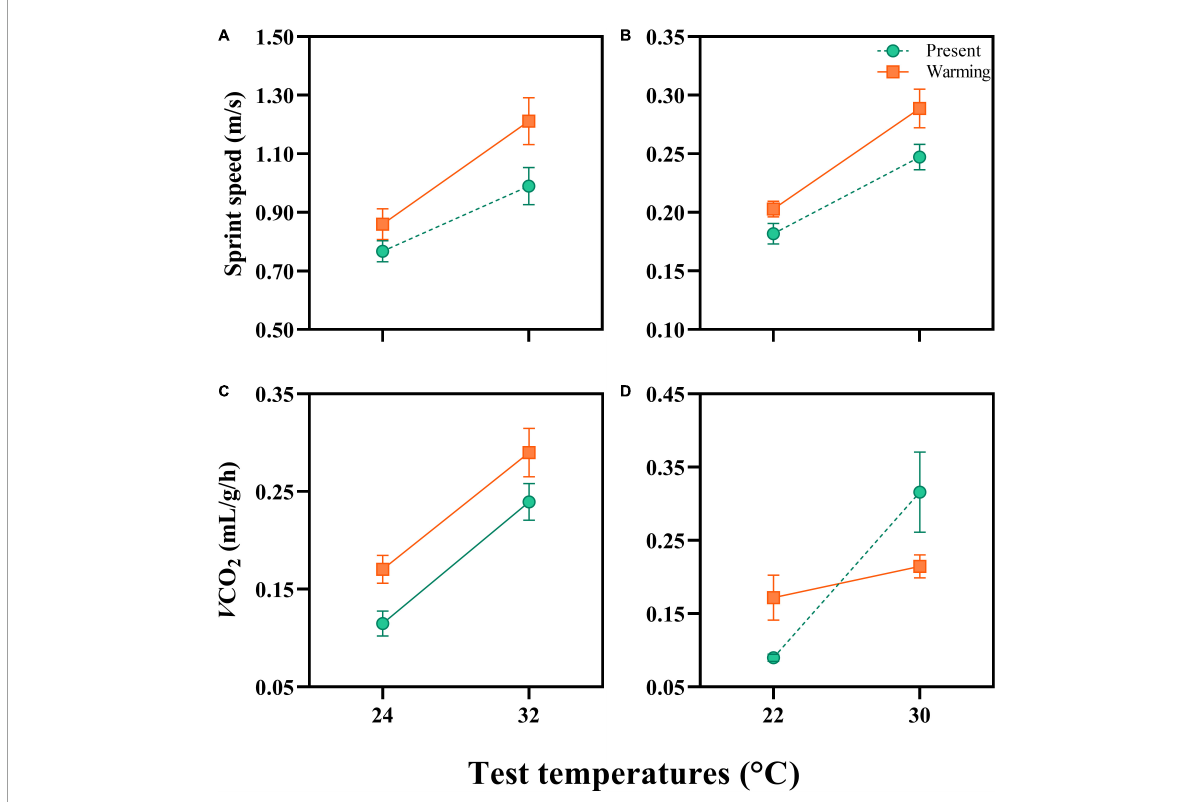
FIGURE2 Sprint speed and resting metabolic rates (RMR) of Eremias argus (A,C) and Takydromus amurensis (B,D) from the present and warming climate conditions. The test temperatures for E. argus were 24 and 32 ◦ C, and for T. amurensis were 22 and 30 ◦ C, respectively. Green and Orange dots and lines indicate the present and warming climate conditions, respectively. Data are shown as mean ± standard error